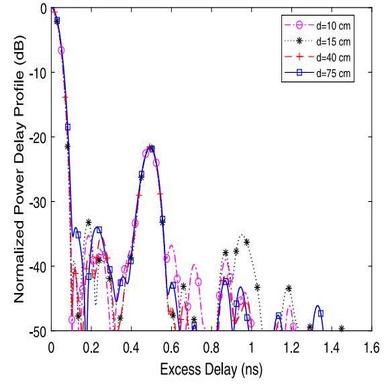
Normalized power delay profile in LoS channel.